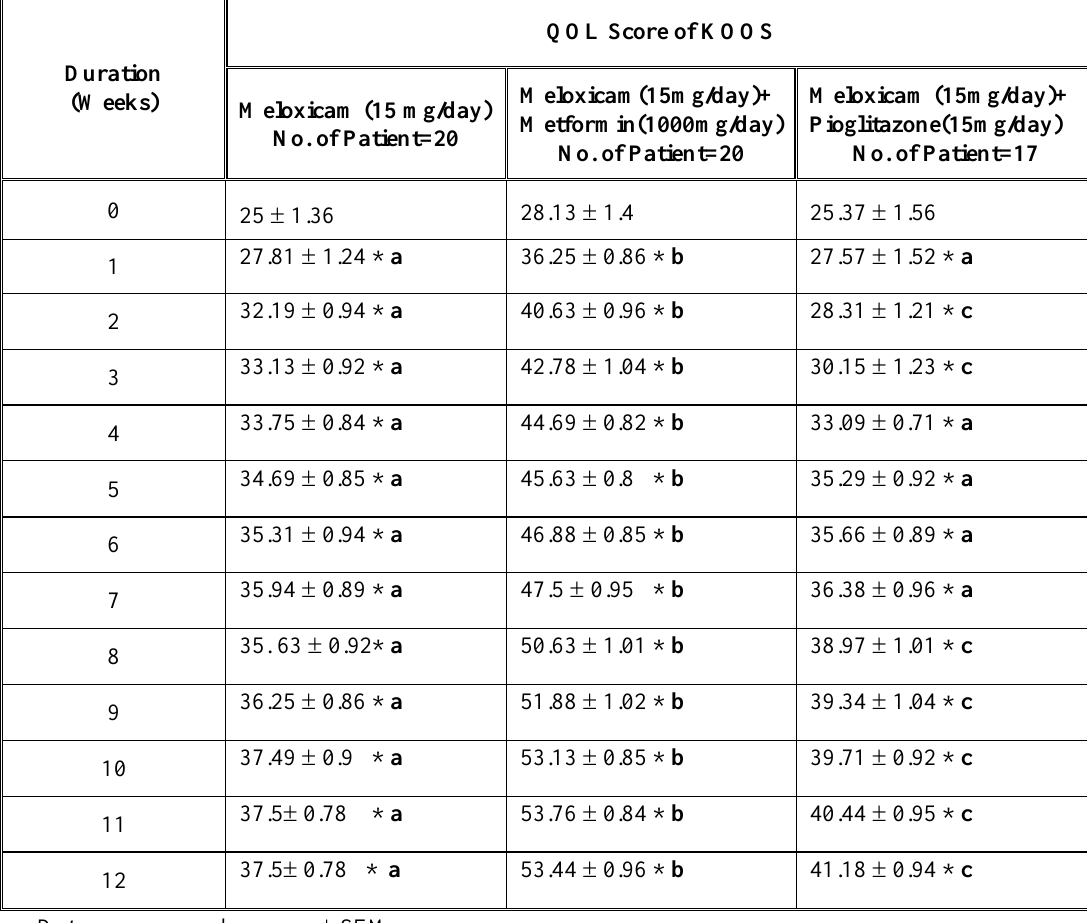
Table (5): Effects of treatment with meloxicam alone, combination of meloxicam + metformin, and meloxicam + pioglitazone on Quality of Life (QOL) score in osteoarthritic